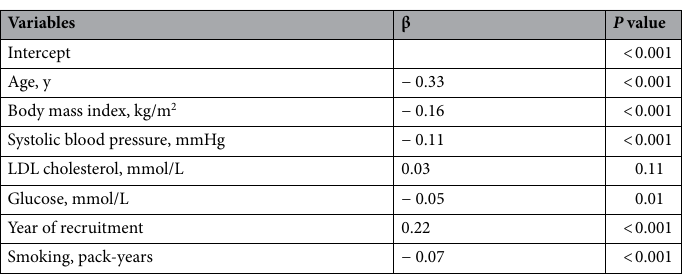
Table 3. Multivariate analysis of the relations between FMD and variables in never smokers and current smokers in men. Initial factors included in the model were age, body mass index, systolic blood pressure, LDL cholesterol, glucose, and year of recruitment. FMD, flow-mediated vasodilation; LDL, low-density lipoprotein.